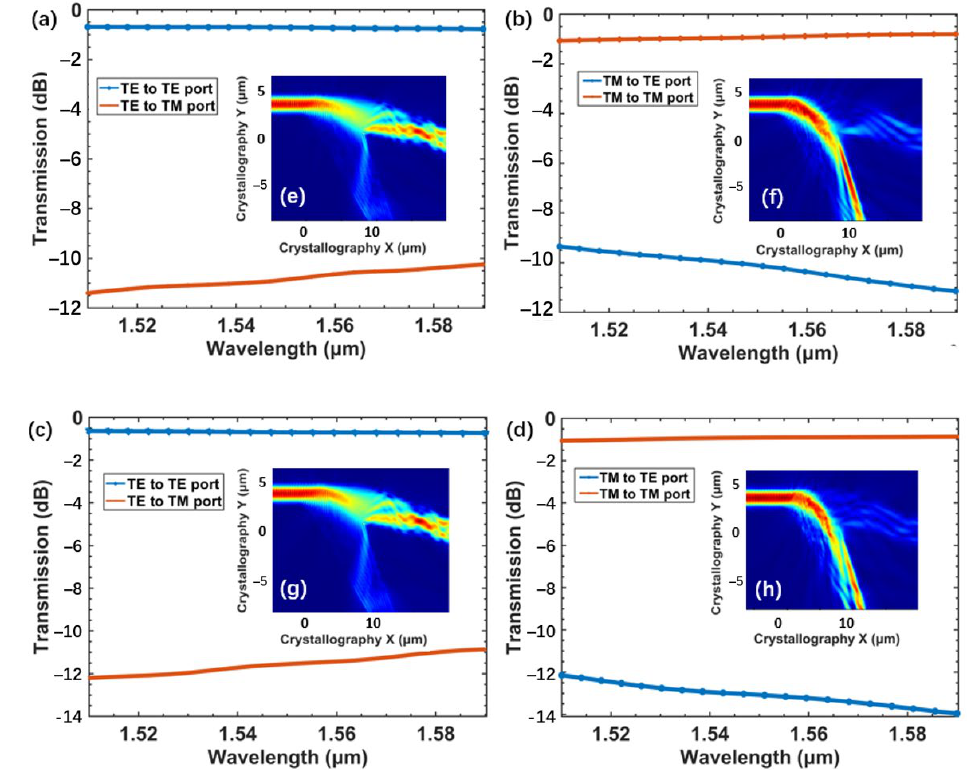
Figure 5. ( a ) Device performance when suffering 20 nm over-etch for TE mode and ( b ) TM mode. ( c ) Device performance when suffering 20 nm under-etch for TE mode and ( d ) TM mode. To elucidate the tolerance of our device to small changes in device geometry, we simulated the device behavior under irregular etching conditions. Considering the outer proximity effect during the etching process, an etched shape close to a round hole is used to replace the ideal square etched air hole. The simulation results under this circumstance indicate that the device is robust to small geometry changes, as shown in Figure 6a,b, while ERs of both the TE and TM mode are above 10 dB, and ILs remain smaller than 1.07 dB over the entire 80 nm bandwidth from 1510 nm to 1590 nm. Considering that the metasurface layer of the device needs to be formed on a standard SOI, there is a high possibility of deviation in the layer from the ideal position. We simulated the device performance when the additional layer deviates from the ideal position by 1 µ m toward the input port, as shown in Figure 6c,d. The results show that the separation function of the PBS device is still efficient, with low ILs (<1.36 dB for TM mode, and <0.79 dB for TE mode) over the entire 80 nm bandwidth and fairly low ERs (>9 dB for TM mode and >11.5 dB for TE mode) in the C-band. The simulation results indicate that the metasurface PBS is suitable for future WDM and PDM communication applications in SOI platform.